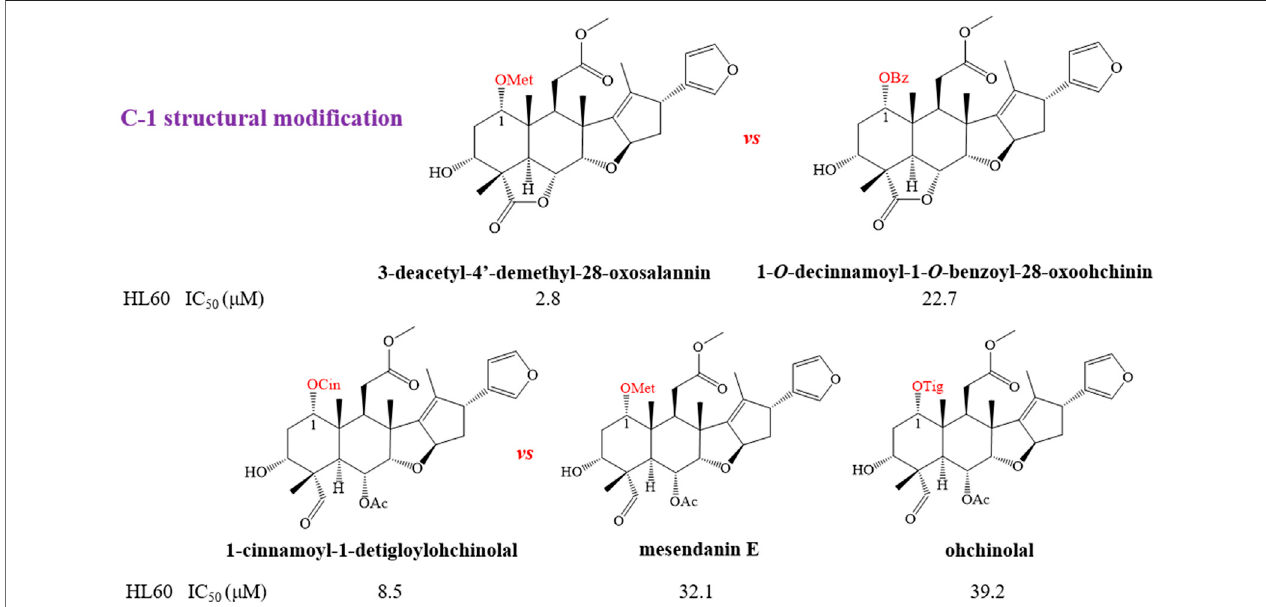
FIGURE 10 | (continue) The anti-tumor structure — activity relationship of